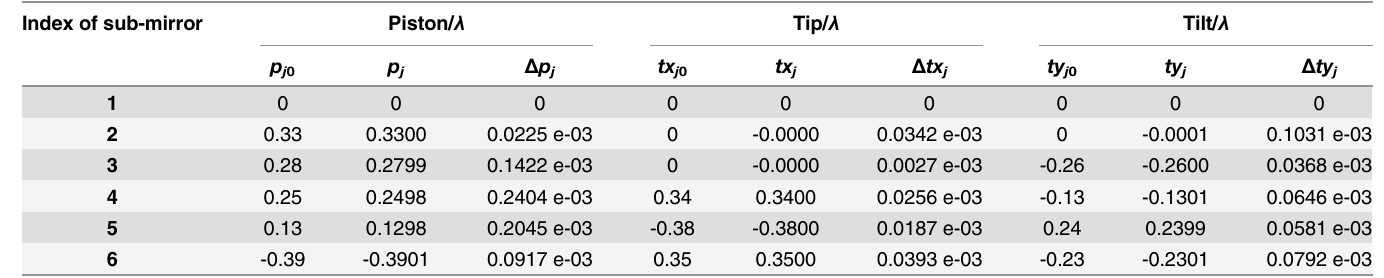
Table 2. Reconstructed wavefront aberration coefficients and residual